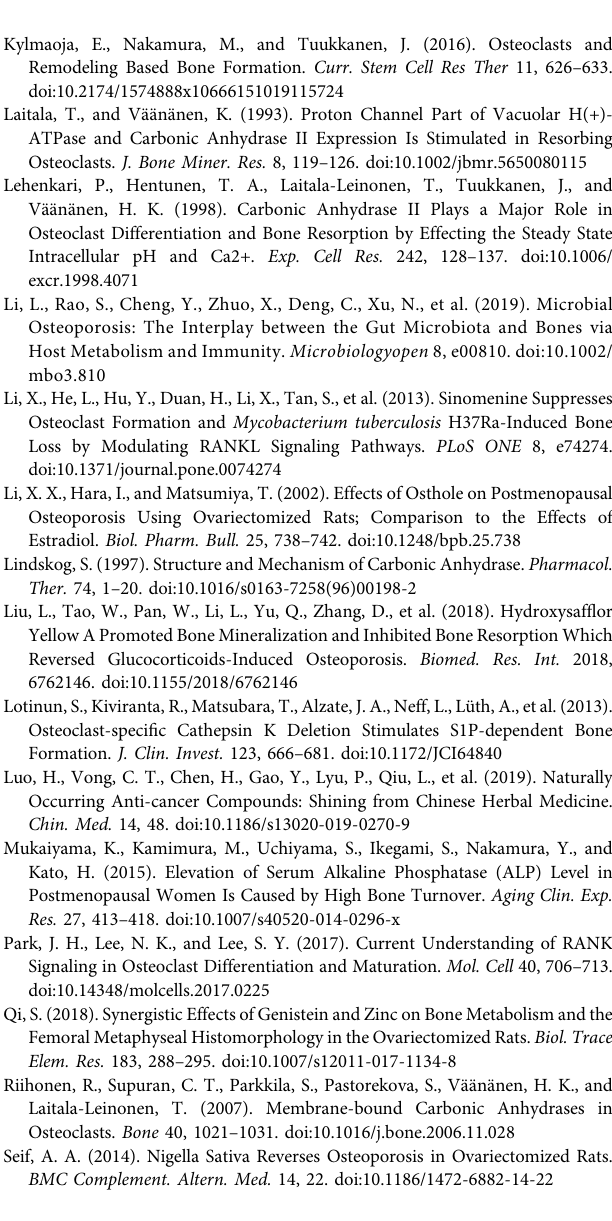
SupplementaryFigure1| ResultsofGipsastainingofvaginalsecretionsinrats. (A) Rats in the model group (B) Rats in the depot group. Supplementary Figure 2 | Morphology of rat ovaries after intervention. Supplementary Figure 3 | Femoral strength test method in